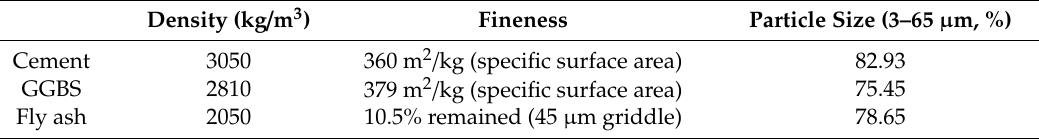
Table 2. Physical characteristics of cement, fly ash, and GGBS.